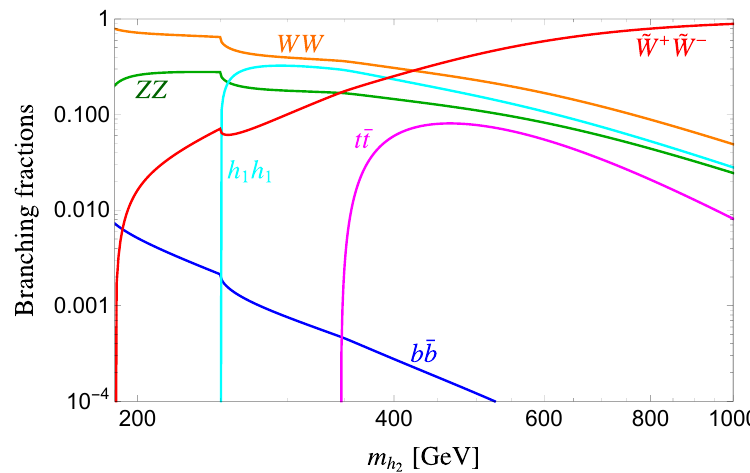
Figure 4. Branching fractions of heavy Higgs h 2 decay versus m h fixed as BM1 in table